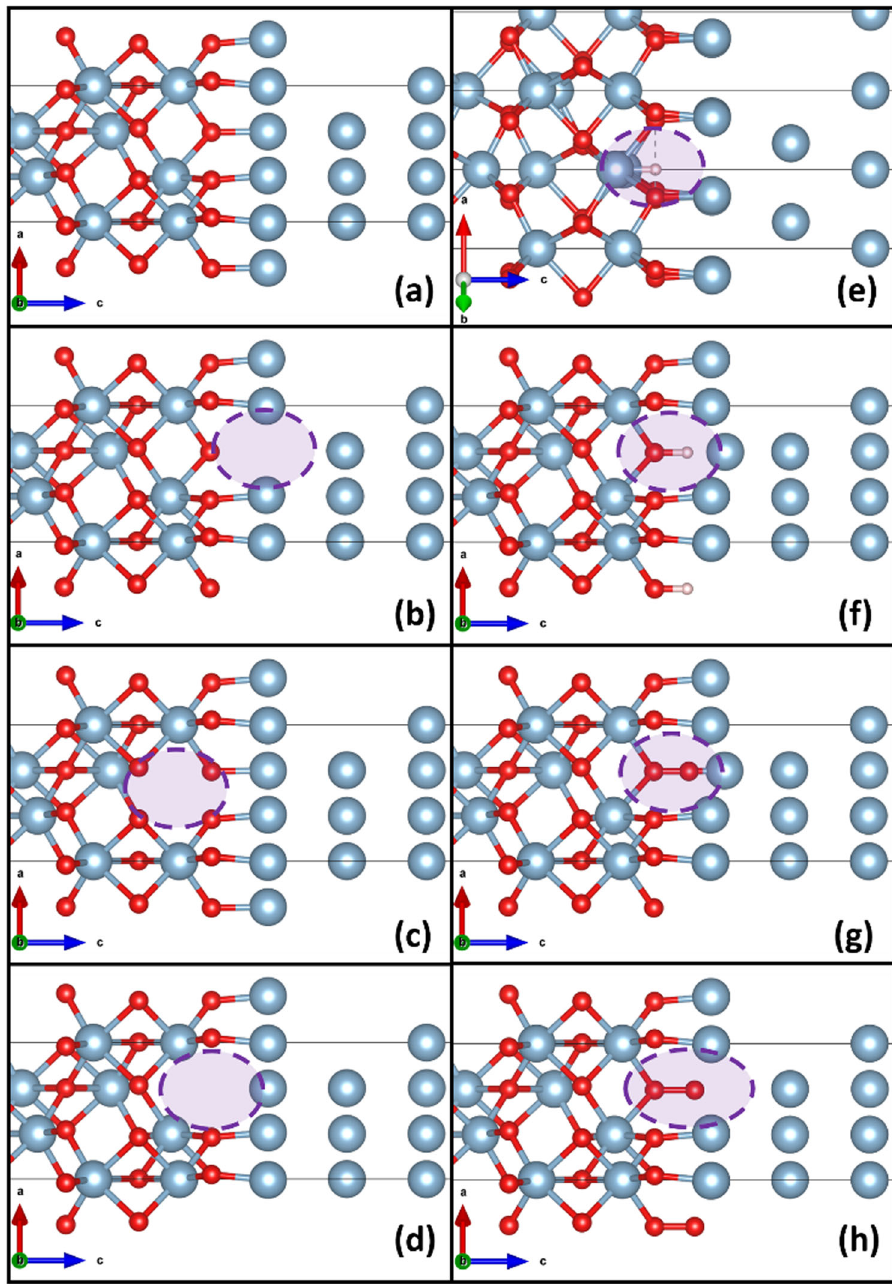
Fig. 3 The atomic models investigated in our demonstration, where the purple elipses indicate the defect location. a Reference structure. b Al vacancy in the metal cap. c Al vacancy in the oxide. d O vacancy in the oxide, e trapped H, f trapped OH, g trapped O 2 , and h Al for O